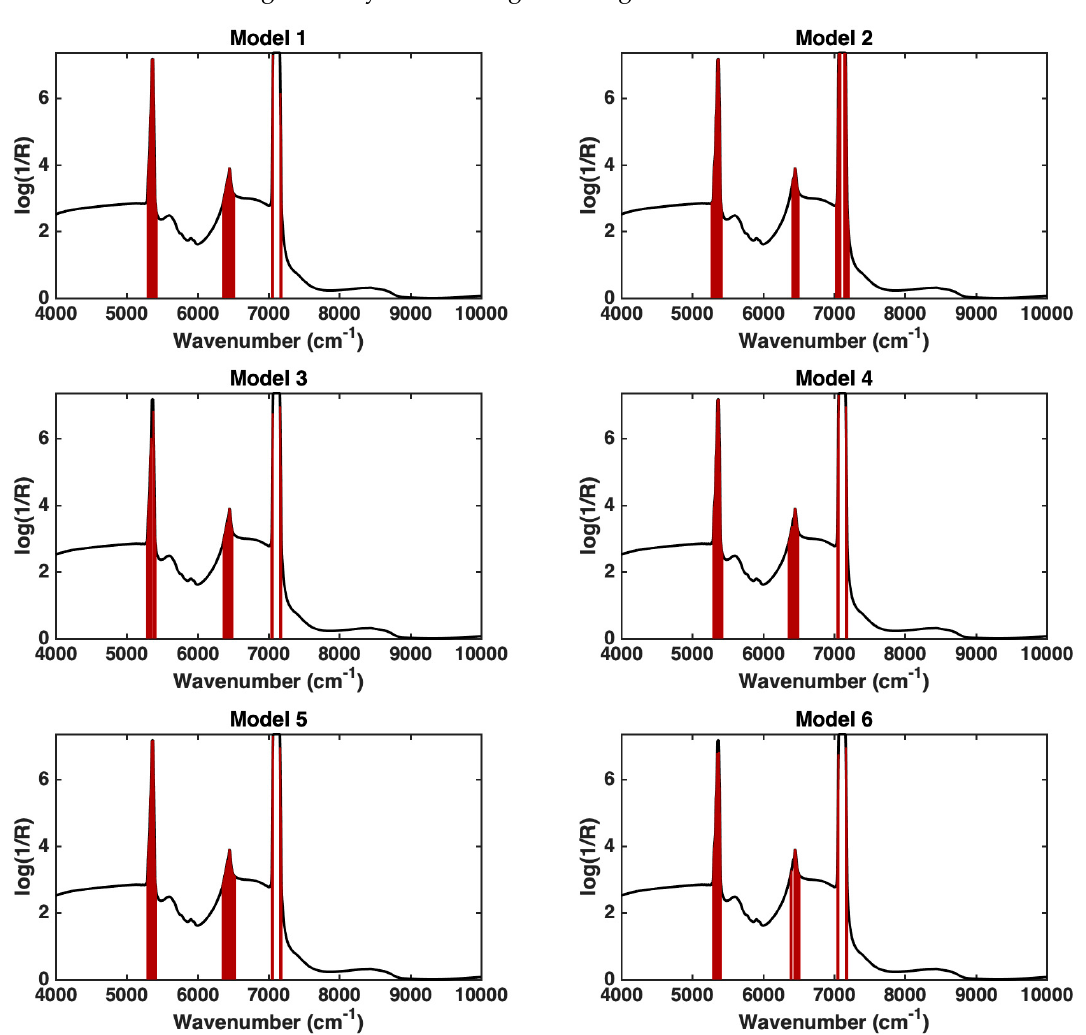
Figure 4. Variables identified as significantly contributing to the six calculated PLS models according to the VIP analysis. For each model, the variables with VIP > 1 are highlighted as dark red bars over the mean spectrum of the training samples (black line).